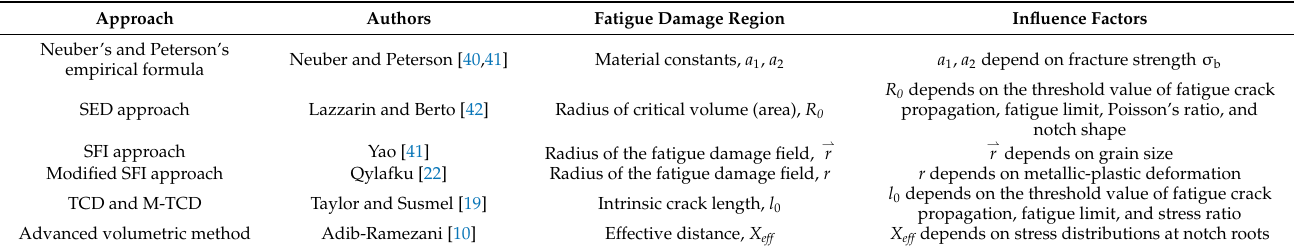
Table 2. Fatigue damage regions of different